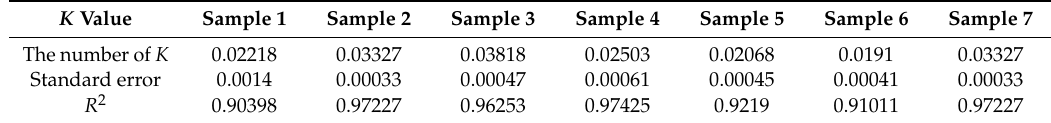
Figure 11. S / G model fitting curve of glycerol contact angle (Sample 7). Figure 11. S/G model fitting curve of glycerol contact angle (Sample 7). Table 4. K value of glycerin on the